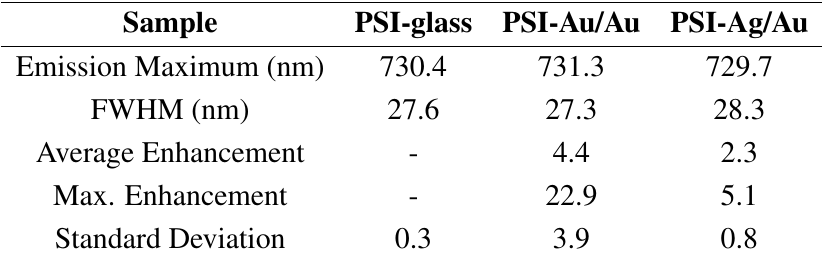
Comparison of enhancement factors, linewidths and standard deviations of enhancement factors observed for uncoupled and coupled PSI